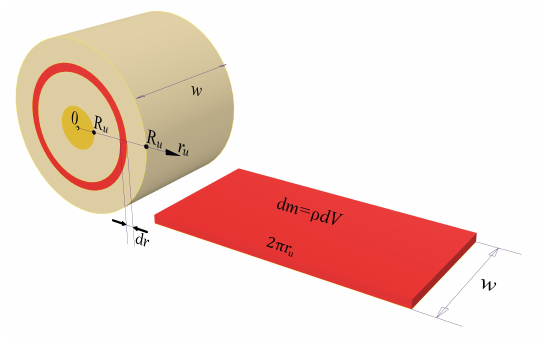
Figure 3. Moment of inertia of the